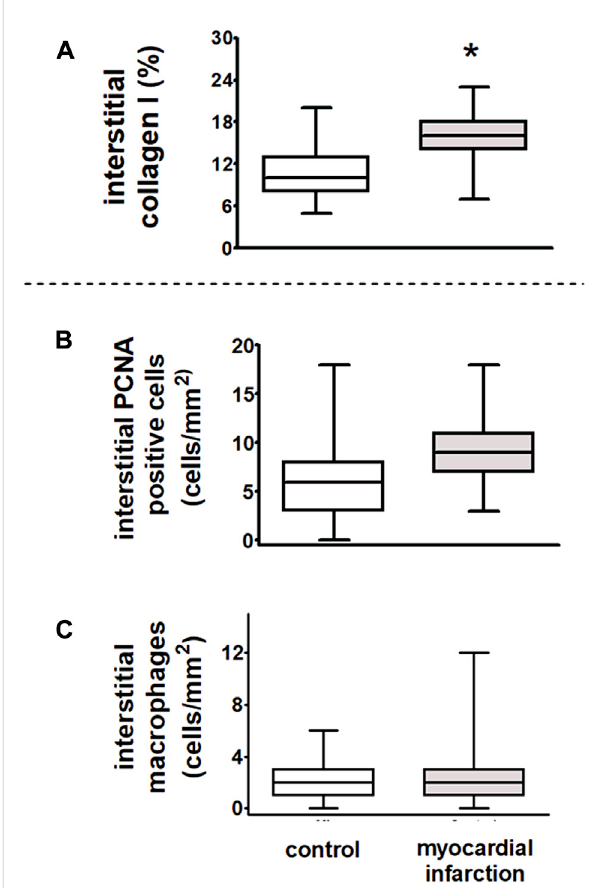
FIGURE 9 Dysregulation of renal sympathetic nerve activity and increase in collagen I expression after myocardial infarction in rats. After myocardial infarction, the fi brosis marker collagen I was increased in rats with myocardial infarction ( n = 9) as compared to controls ( n = 6). (A) Interstitial collagen type I (in % interstitial area, myocardial infarction versus controls, * p < 0.05). Myocardial infarction did not in fl uence in fl ammatory in fi ltration of the renal interstitium as compared to control animals. (B) Interstitial proliferating cell nuclear antigen (PCNA)-positive cells (in cells/mm 2 , myocardial infarction versus controls, n = six per group); (C) interstitial macrophages (in cells/mm 2 , myocardial infarction versus controls, n = six per group). Kruskal – Wallis one-way ANOVA on ranks was used with Dunn ’ s post - hoc method. Rats were taken from the groups of rats with myocardial infarction or SHAM